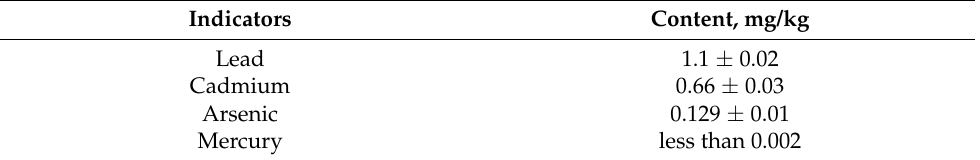
Table 3. The content of toxic elements in the C. sorokiniana biomass.